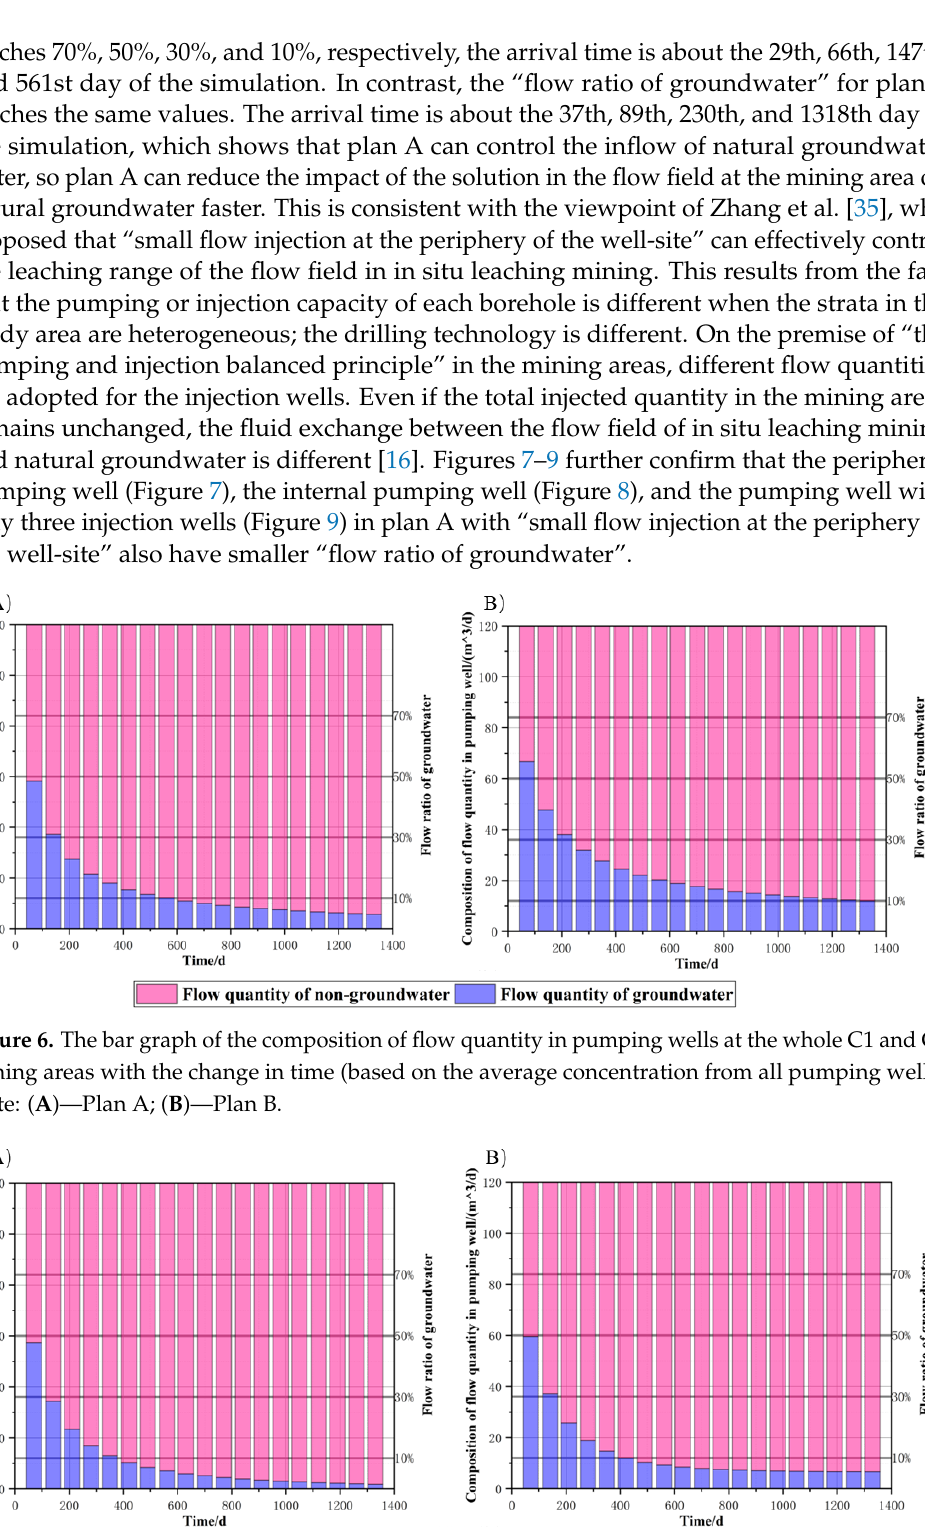
Figure 7. The bar graph of the composition of flow quantity in pumping well BC2204 with the change in time. Note: ( A ) ‐ Plan A; ( B ) ‐ Plan B.